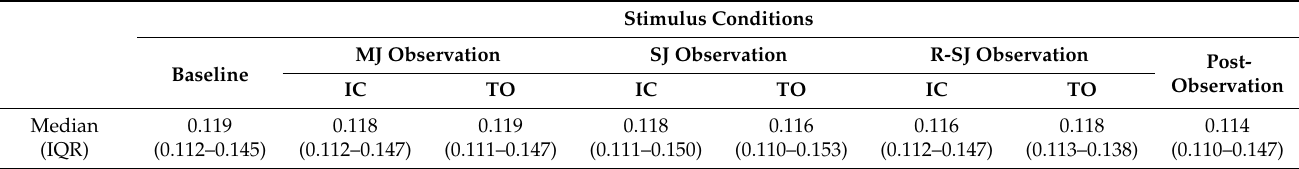
Table 1. Median and IQR values of the background EMG activity in the TA muscle during baseline, MJ observation, SJ observation, R-SJ observation, and post-observation conditions.